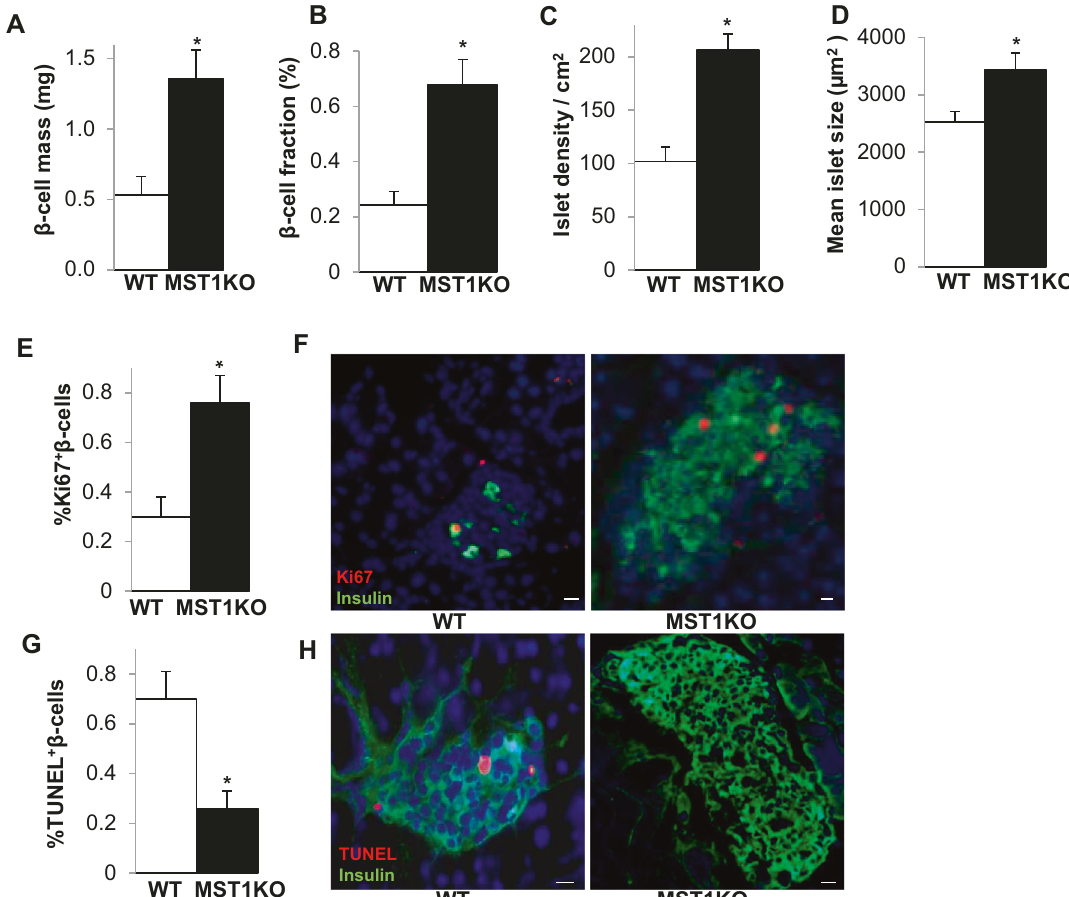
Fig. 2 MST1 deletion protects pancreatic β -cells in HFS/STZ-model of diabetes. Whole body MST1KO ( n = 5) and WT ( n = 6) mice were fed a high fat/ high sucrose diet (HFS) for 16 weeks and thereafter injected with a single dose of STZ (100 mg/kg) and kept for 3 more weeks under HFS treatment. Fixed, paraf fi n-embedded mouse pancreas sections spanning the width of the pancreas were stained for insulin and A β -cell mass as cross-sectional area of insulin-positive cells/whole pancreas × pancreas mass in mg, B percentage of β -cell fraction of the whole pancreas C islet density/cm 2 pancreas and D mean islet size was analyzed using NIS-elements microscopical analysis software. Quantitative analyses ( E , G ) and representative images ( F , H ) from triple staining for Ki67 ( E , F ) or TUNEL ( G , H ), insulin, and DAPI expressed as a percentage of TUNEL- or Ki67-positive β -cells ±SEM. Data are expressed as means ± SEM. * p < 0.05 MST1KO compared to WT littermates. Scale bars depict 20 μ